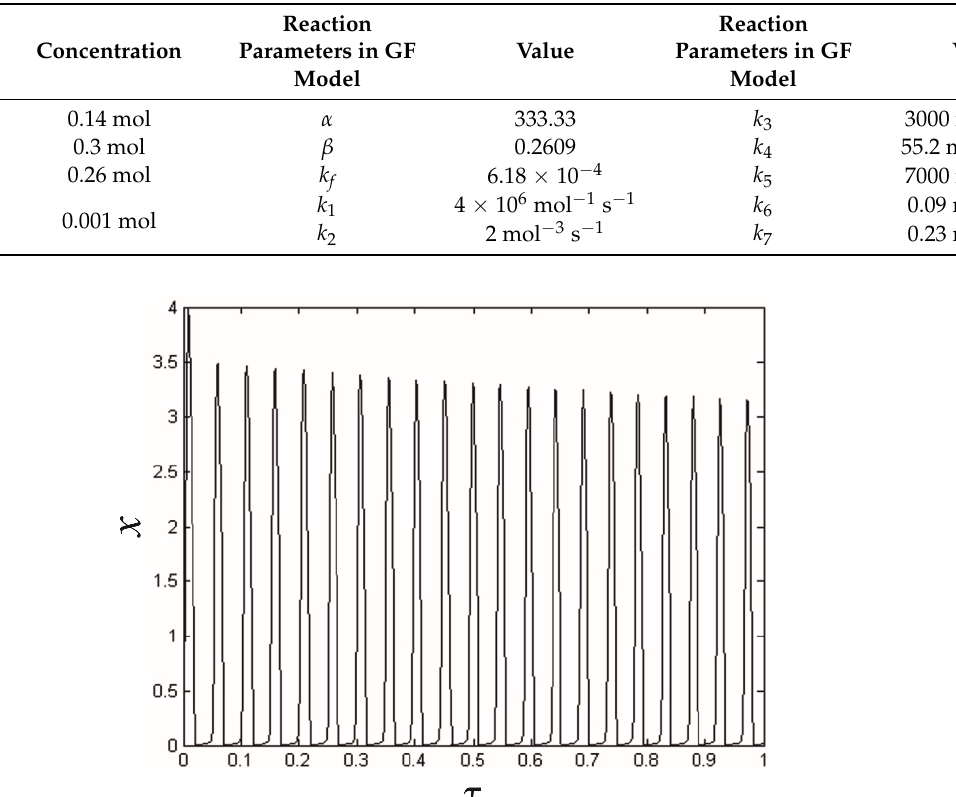
Table 2. The concentrations of intermediate species and the values of reaction parameters in GF model for oscillatory behavior at high flux.